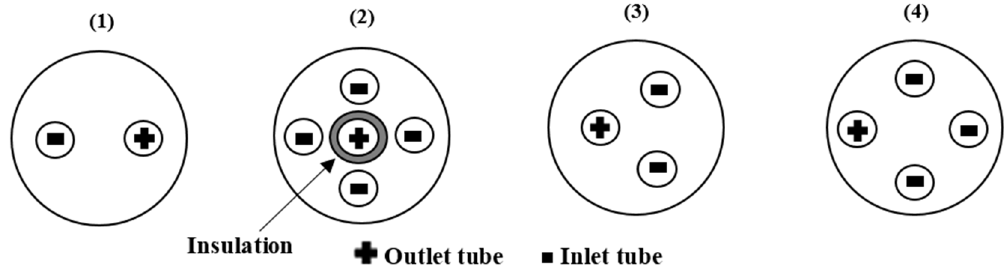
Figure 9. Cross sections of four ground heat exchangers (GHEs): ( 1 ) single U-tube, ( 2 ) multi-tube, ( 3 ) three-tube, and ( 4 ) four-tube.